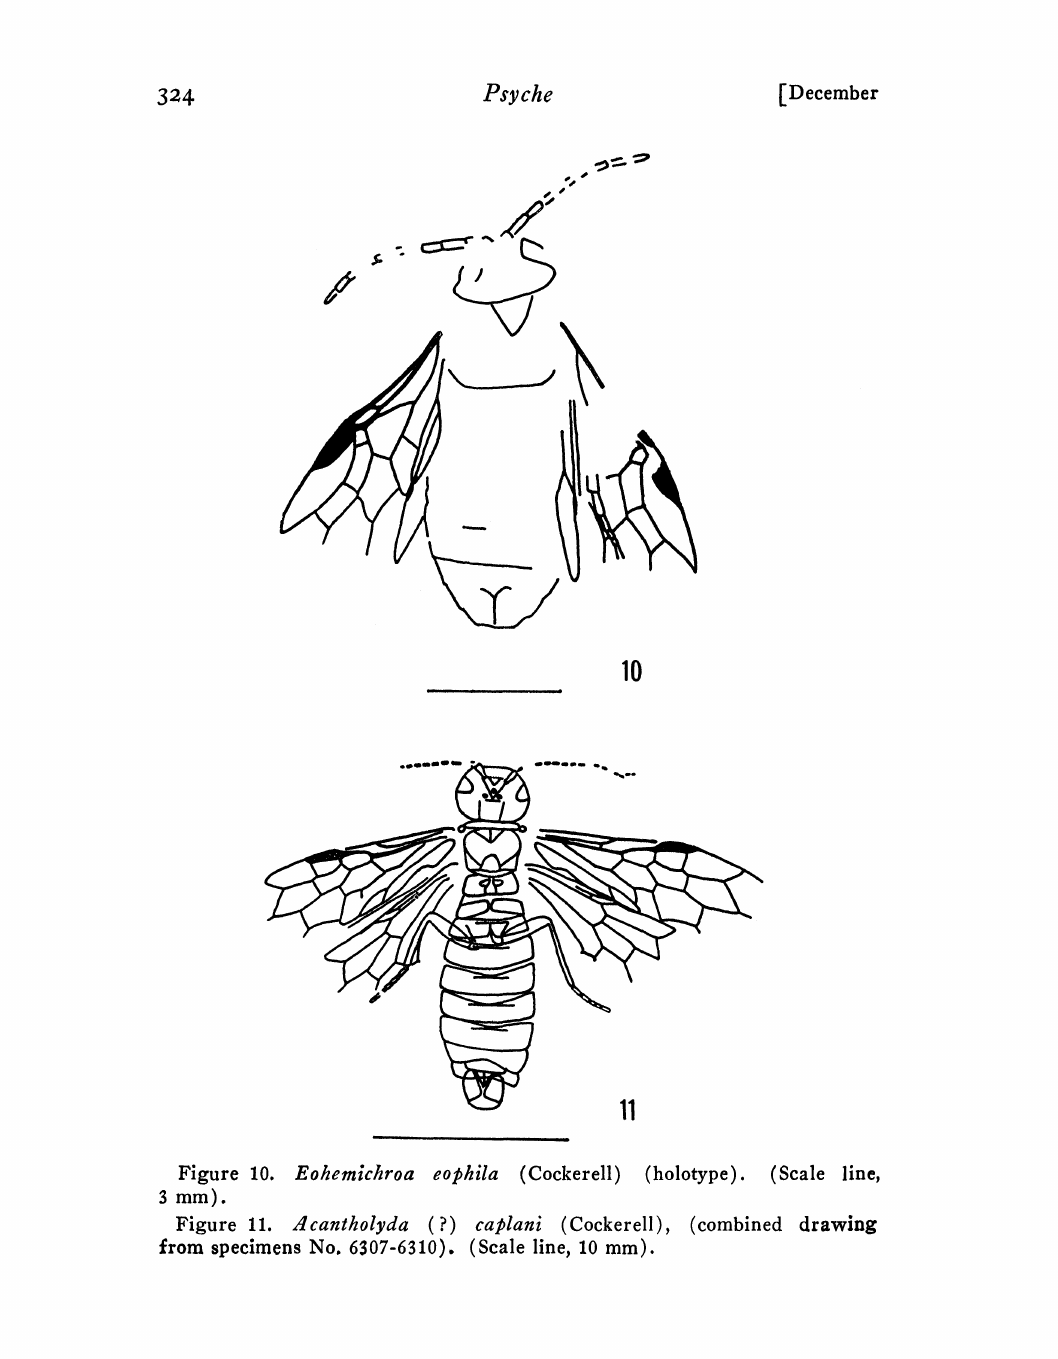
Figure 10. Eohemichroa eo#hila (Coekerell) (holotype). (Scale line, 3 mm). Figure 11. lcantholyda (?) ca#lani (Coekerell), (combined drawing from specimens No. 6507-6310). (Scale line, 10